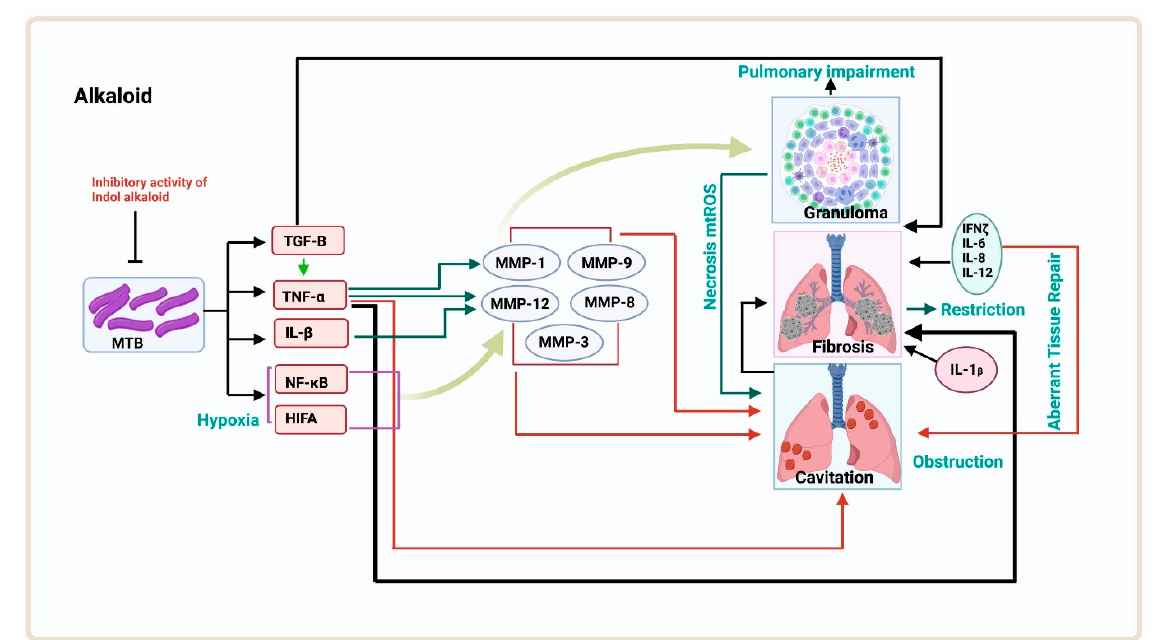
Figure 3. The isolated compound from the plant shows inhibitory activity on MTB. The MTB cells in hypoxia conditions produce HIFA, NF- κ B, IL-1B, and TNF- α , and these proteins lead to the production of MMP-12, MMP-3, MMP-1/MMP-8, and MMP-9 inhibitors. The production of these matrix metalloproteinases leads to cavitation in the lungs, or MMP-12 and MMP-1 together produce granuloma, which leads to pulmonary impairment or necrosis, leading to cavitation followed by obstruction. Cavitation causes fibrosis in between the mechanism of aberrant tissue repair.